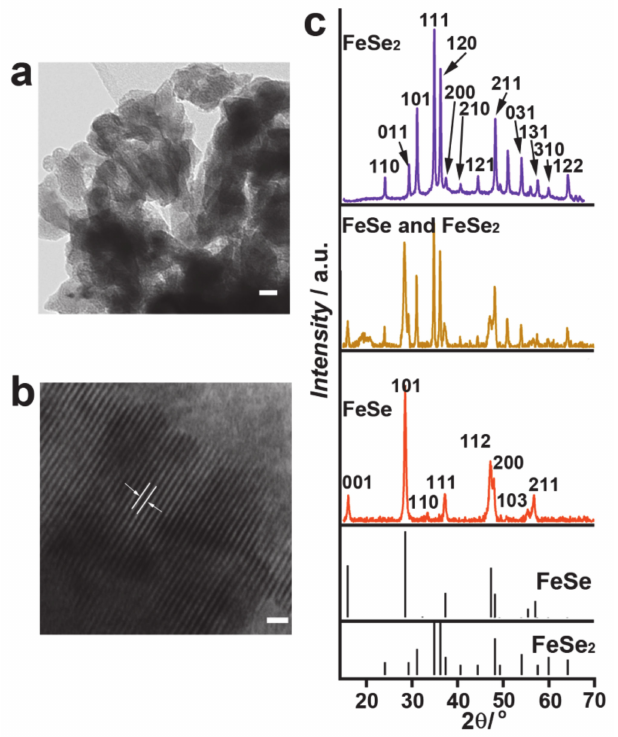
Figure 5. TEM ( a ) and HRTEM ( b ) analysis of as-prepared FeSe NCs, the lattice spacing is 5.9 ± 0.2 Å, and the scale bar is 20 nm and 2 nm, respectively. ( c ) A series of XRD patterns derived from preparing FeSe nanocrystals through extracting Se from FeSe 2 . The vertical line on the bottom corresponds to tetragonal FeSe (PDF = 85-0735) and orthorhombic marcasite-type structures of FeSe 2 (PDF = 21-0432),